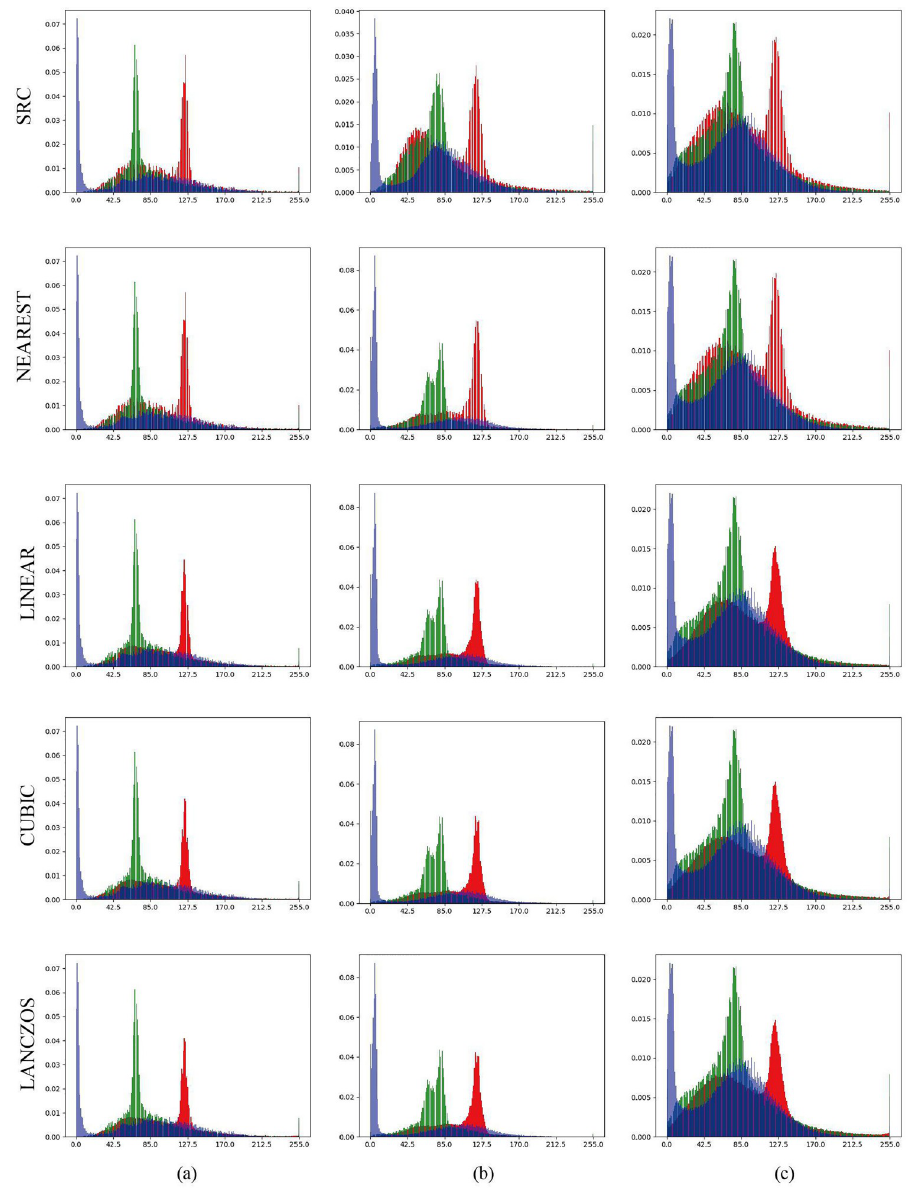
Fig 8. Comparison of several image scaling processing methods. Columns ( a ), ( b ), and ( c ) show the pixel distribution statistics of 128 × 128, 256 × 256, and 1024 × 1024 images, respectively, enlarged or reduced to 512 × 512. NEAREST: nearest neighbor interpolation. LINEAR: bilinear interpolation. CUBIC: bicubic interpolation of a 4x4 pixel neighborhood. LANCZOS: Lanczos interpolation of a 8x8 pixel neighborhood.